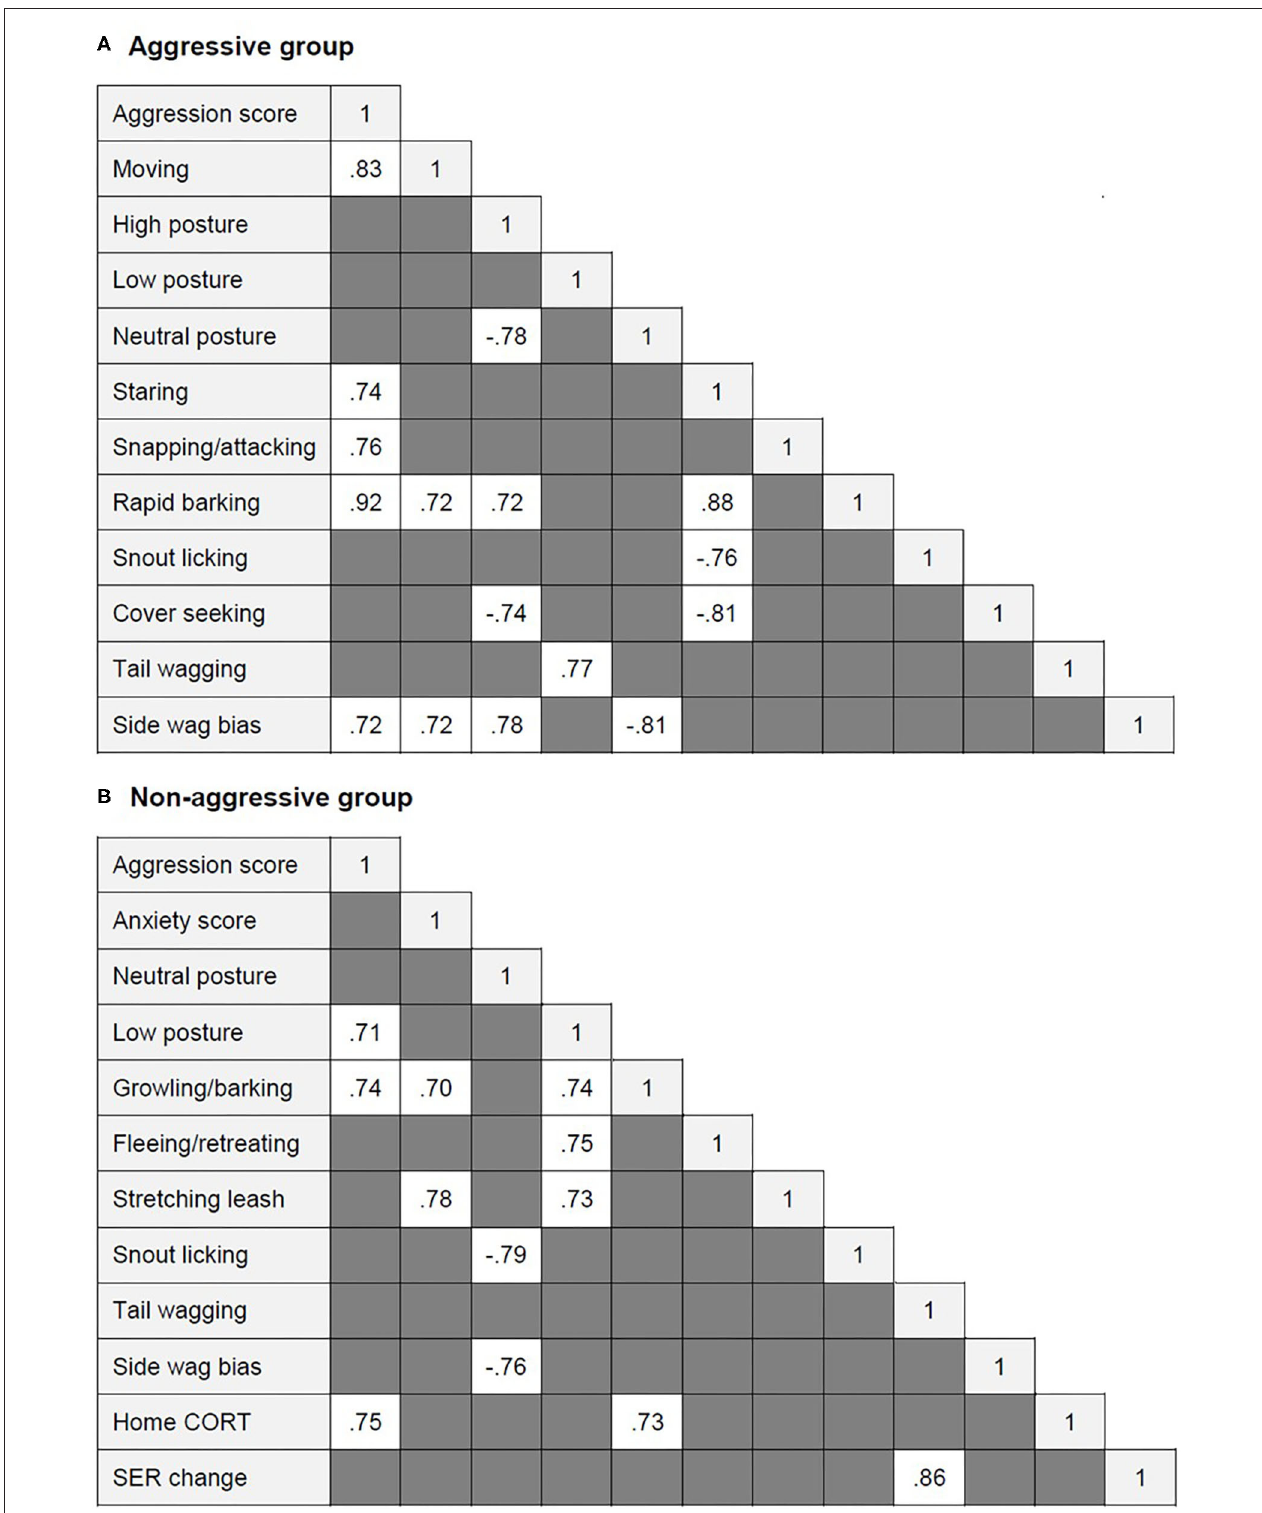
FIGURE 2 | Significant correlations between aggression and anxiety score, behavioral and physiological variables (when r ≥ 0.7) within (A) the aggressive group and (B) the aggressive group of dogs.